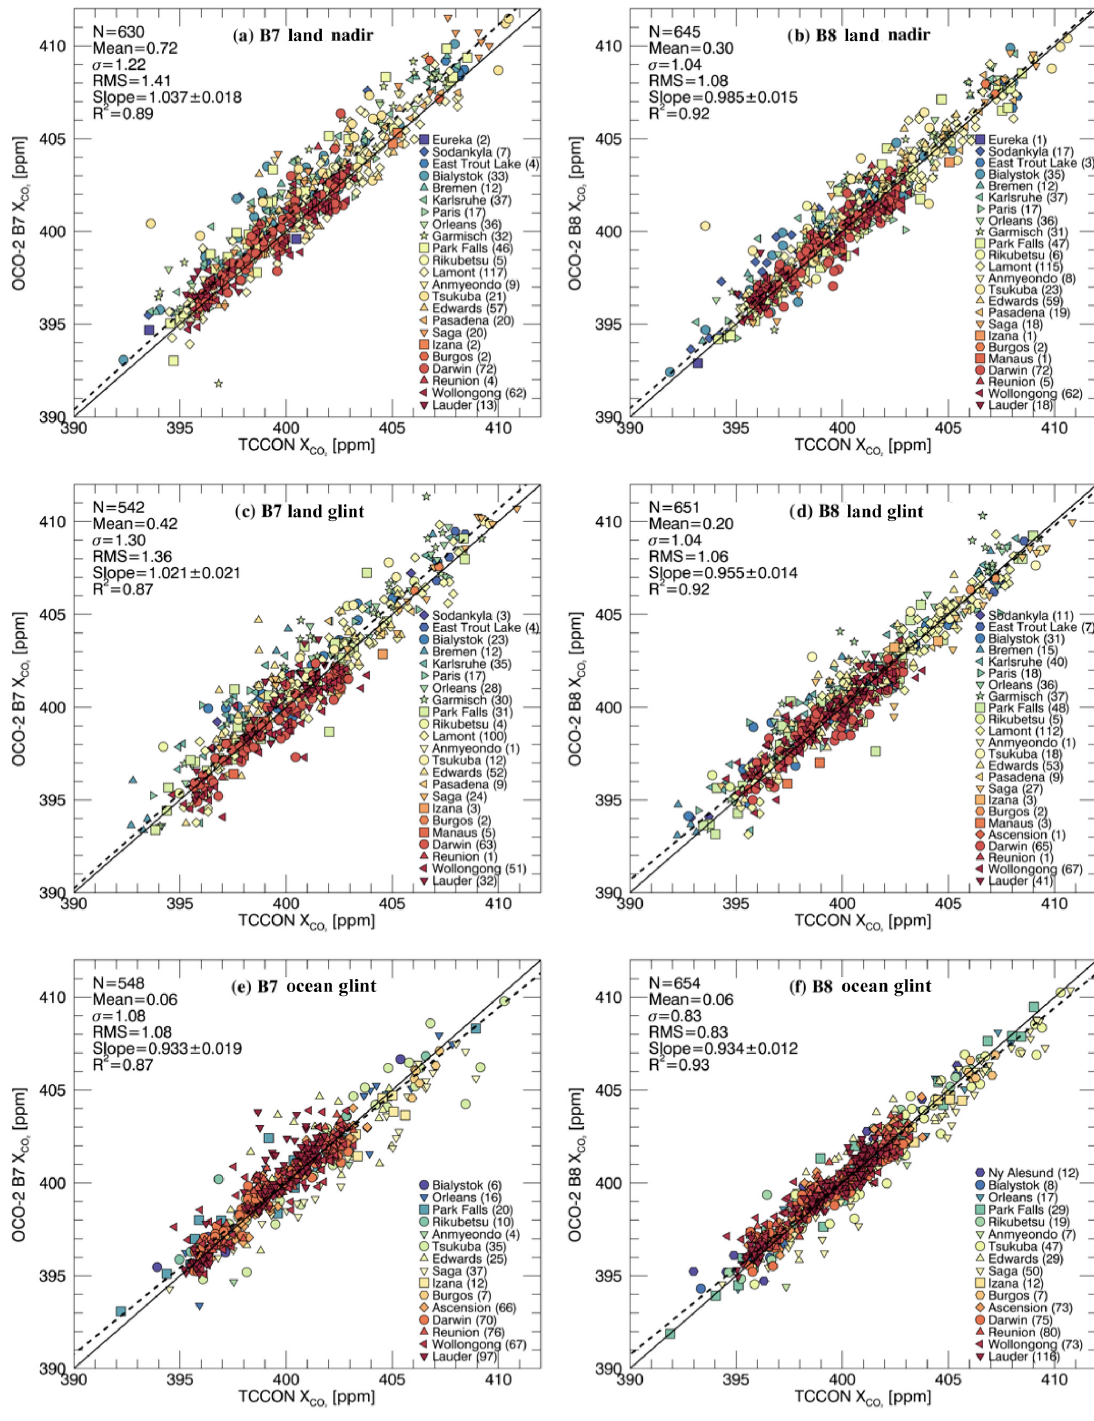
Figure 18. TCCON validation for OCO-2 X CO , versions B7 (a, c, e) and B8 (b, d, f) , for land nadir (a, b) , land glint (c, d) , and ocean 2 glint (e, f) observations. Each symbol represents the overpass–mean comparison for one site overpass, with the total number of overpasses per site given in parentheses. Thus each symbol represents tens to hundreds of OCO-2 observations co-averaged. Quality-filtered and bias- corrected X CO is shown for OCO-2, along with the averaging-kernel correction. The solid line denotes the one-to-one line, and the dashed 2 line is the line of best fit. The colocation strategy is described in the text. Shown in the upper left of each panel are the total number of overpasses ( N ), the mean, standard deviation ( σ ), and rms of the OCO-2 minus TCCON differences, the slope of best fit, and the R 2 of the two data